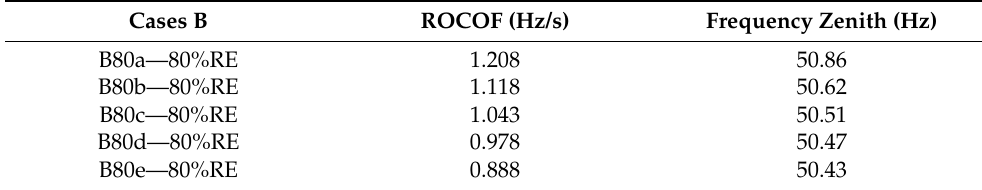
Table 6. ROCOF and frequency zenith for Group B.